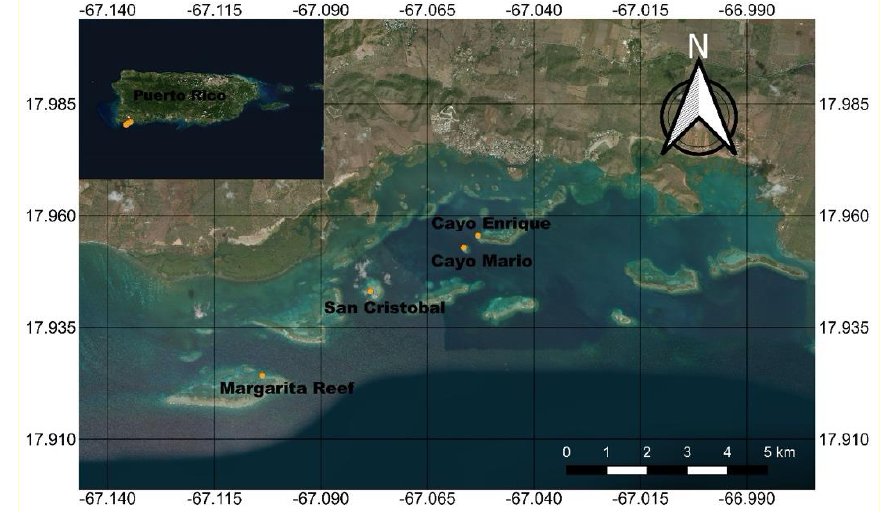
Figure 1. Map of study location, La Parguera, Puerto Rico. During June 2017, six temperature sensors were deployed at Cayo Enrique, and six temperature sensors at Cayo Mario ( n = 12 total). The depths ranged from 1–13 m. In March 2019, eight temperature sensors were deployed at San Cristobal between depths of 5–6 m, and another eight were deployed at Margarita Reef at depths between 3–4 m ( n = 16).